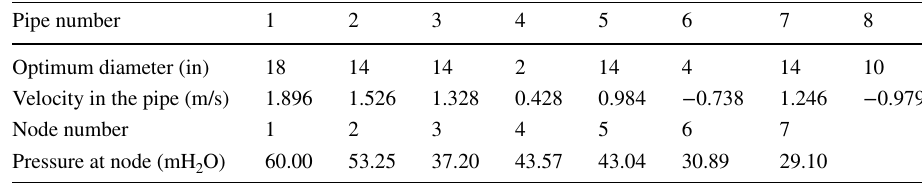
Table 3 Optimal characteristics results by the NSGA-II for two- loop no-leak WDN